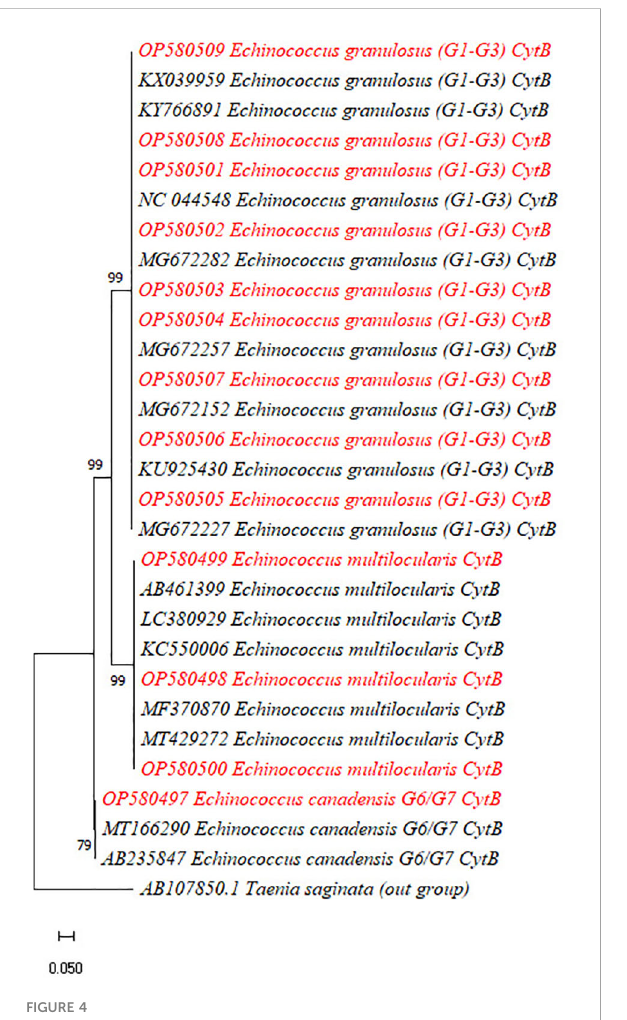
FIGURE 4 Phylogenetic analysis of the currently identi fi ed Echinococcus granulosus , Echinococcus multilocularis , and Echinococcus canadensis species based on the Cyt-b gene. The phylogenetic tree was constructed in MEGA X software using maximum likelihood (Taimura – Nei) methods with a bootstrap value of